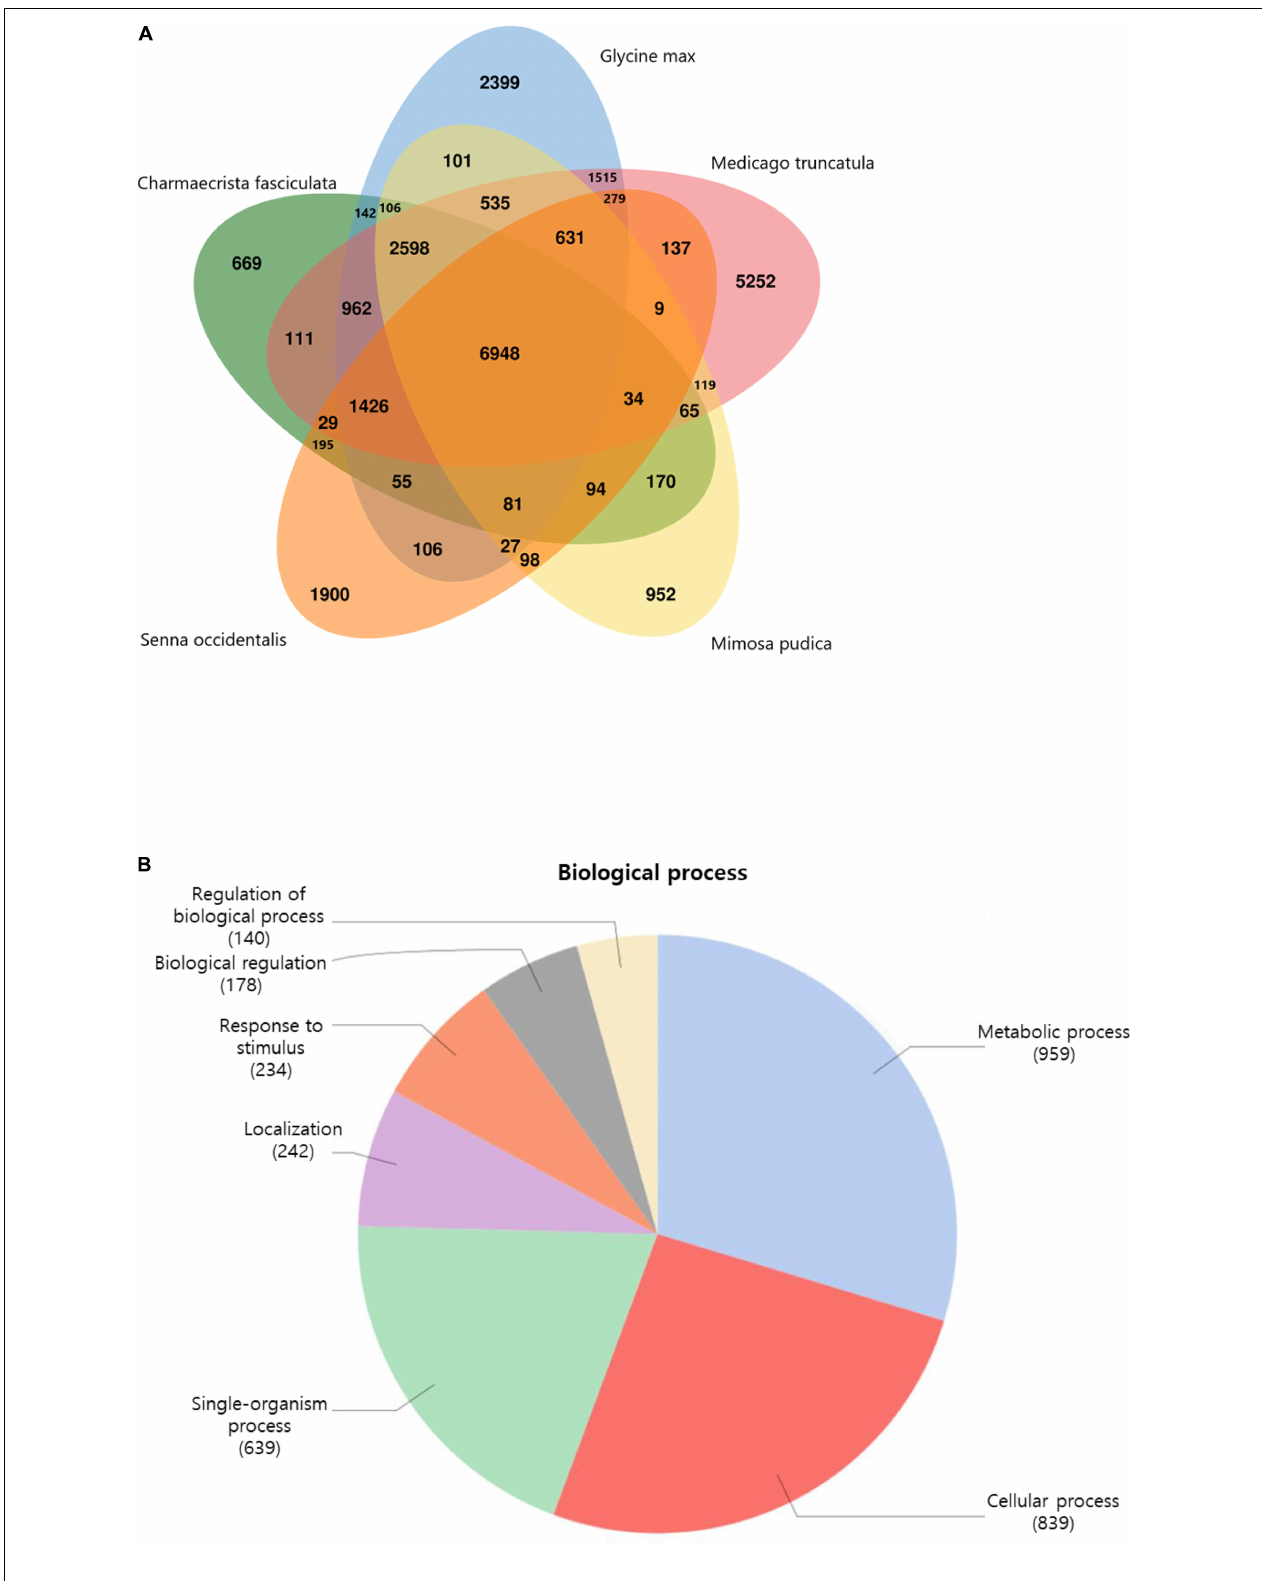
Frontiers in Plant Science |